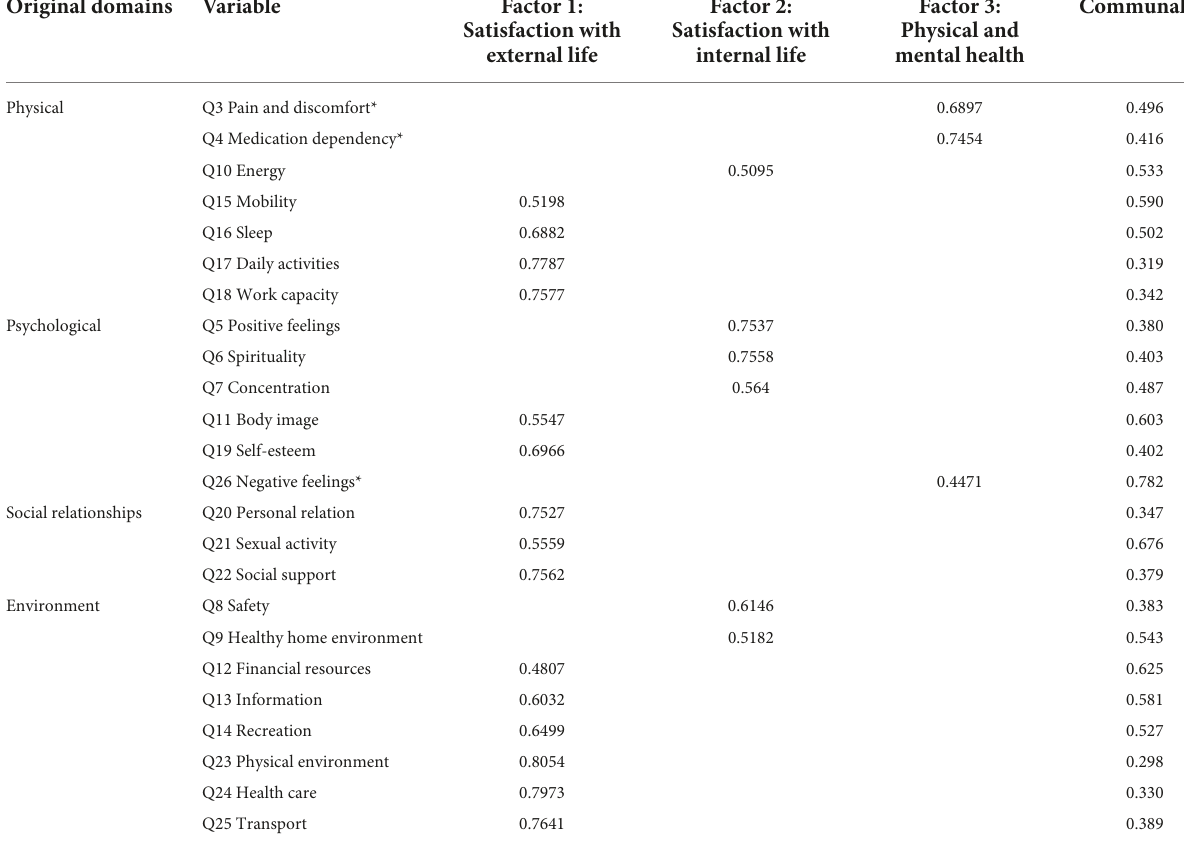
TABLE 2 Exploratory factor analysis for WHOQOL-BREF instrument. Original domains